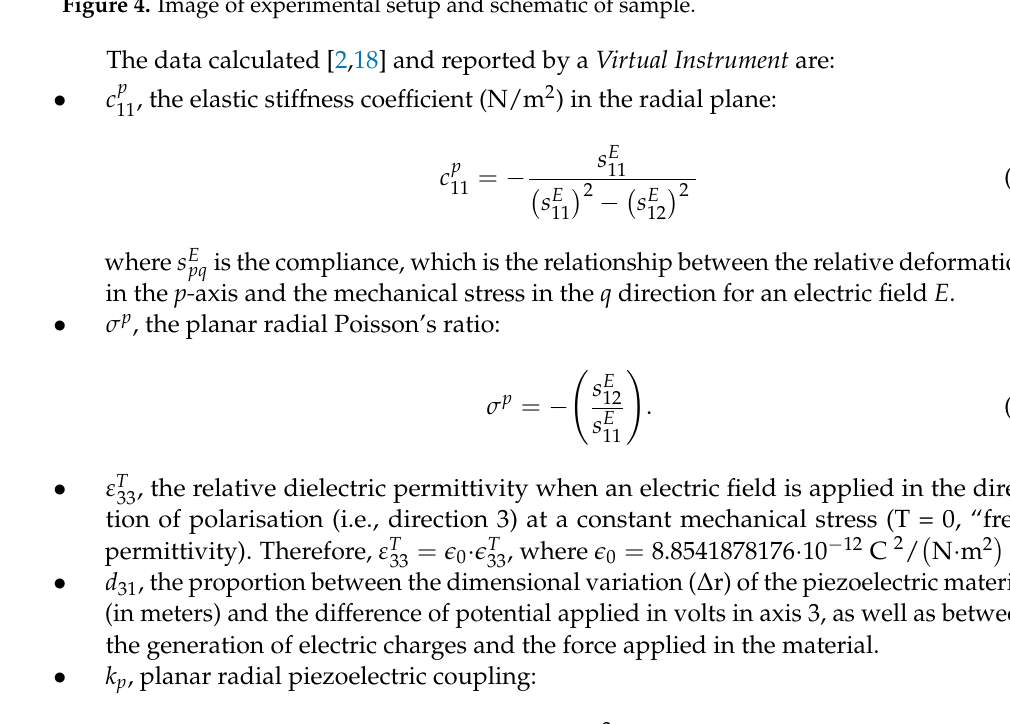
Figure 4. Image of experimental setup and schematic of